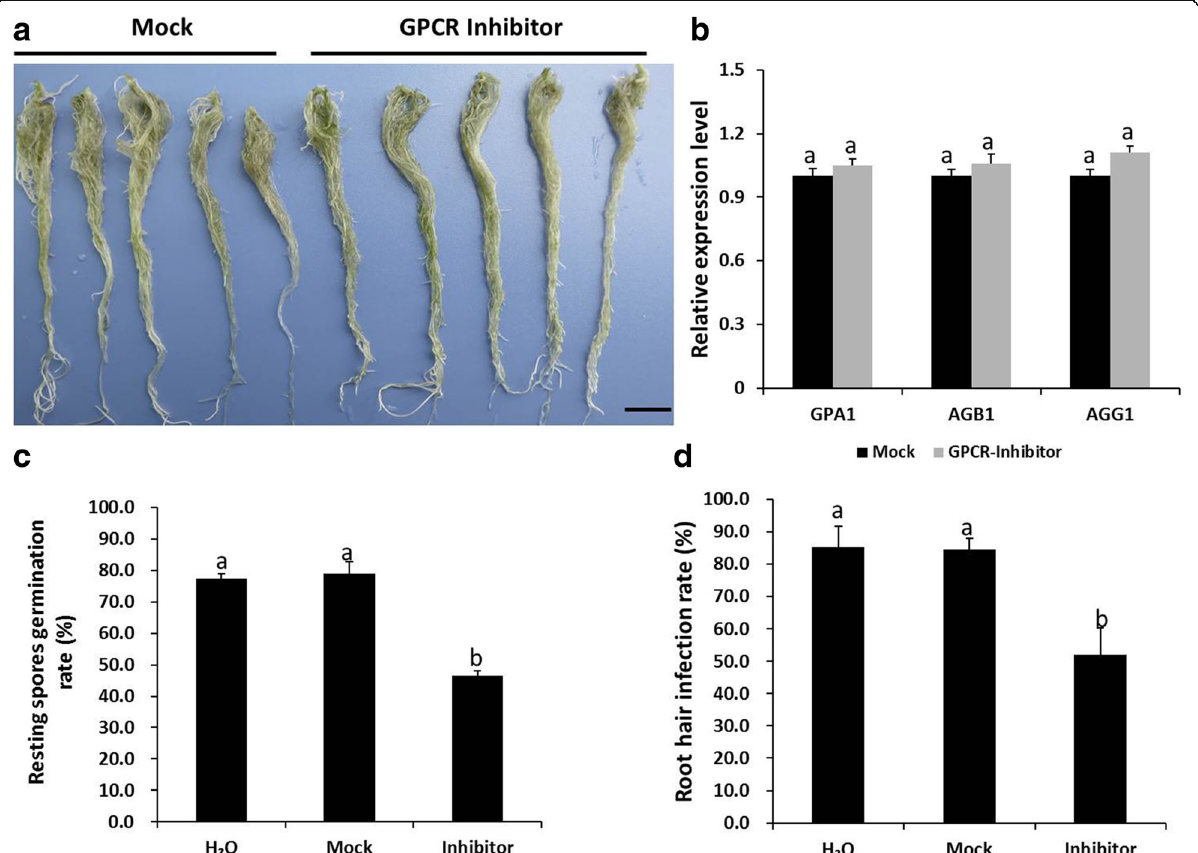
Fig. 5 Effect of GPCR inhibitor treatment on the growth, development of rapeseed plants, resting spore germination rate and root hair infection rate of Plasmodiophora brassicae . a Growth and development status of rape plants treated with GPCR inhibitor (right). Mock (DMSO) treatment served as control (left). The pictures were taken at 28days after treatment. Bar=1.5cm. b At 28days after treatment, the roots of mock- and inhibitor- treated plants were harvested. The expression levels of GPA1 , AGB1 , and AGG1 (downstream genes of GPCRs) in Brassica napus with mock and inhibitor treatment were quantified by qPCR. The actin gene of B. napus was used as control to normalize the expression level. Data represent the means and standard deviations. The expression level of mock-treated group was set as 1.0. Statistically significant difference of data between mock and inhibitor treated groups was compared, and the same letter in the graph indicates no significant differences at the level of P <0.05. c , d Resting spore germination rate and root hair infection rate of P. brassicae were compared between H 2 O , mock and inhibitor treated groups. After 4days, the treated spores were stained with orcein (Sigma-Aldrich Canada). The germination rate of spore was counted under microscope. At 7 dpi, the roots of rapeseed plant were stained with Trypan Blue, and then the root hair infection rate was counted with microscopic examination. The graphic data represent the means and standard deviations from three biological replicates. At the level of P <0.05, statistically significant differences of data between H 2 O , mock and inhibitor treated groups were compared, different letters in the graph indicate statistically significant differences according to Student ’ s t